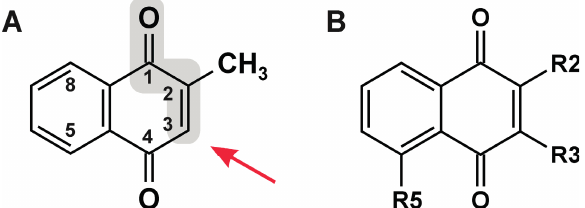
Figure 1. Structures of naphthoquinones. ( A ) Menadione (2-methyl-1,4-naphthoquinone), its α , β -unsaturated carbonyl moiety (gray) and the site of attack of a nucleophile in a Michael-type addition (red arrow); ( B ) Naphthoquinones mentioned in this article (see Table 1 for R2, R3,